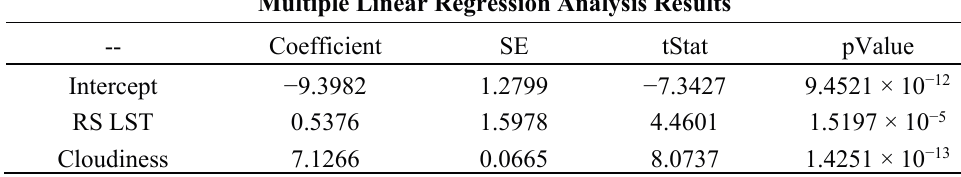
Table 5 . Multiple linear regression model results for in situ LST estimation using RS LST and cloudiness as predictor